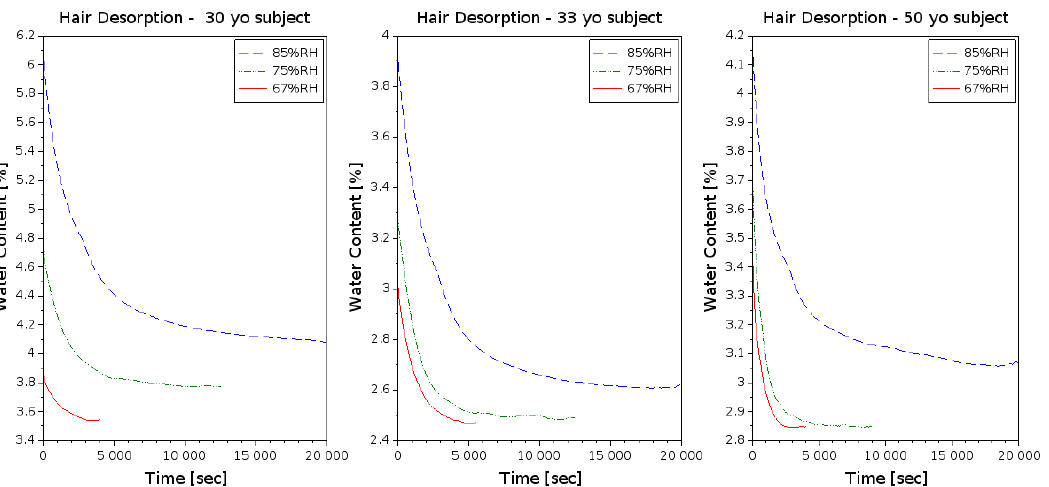
Figure 9. Hair water content desorption curves using samples from three volunteers and for three different humidity acclimatization